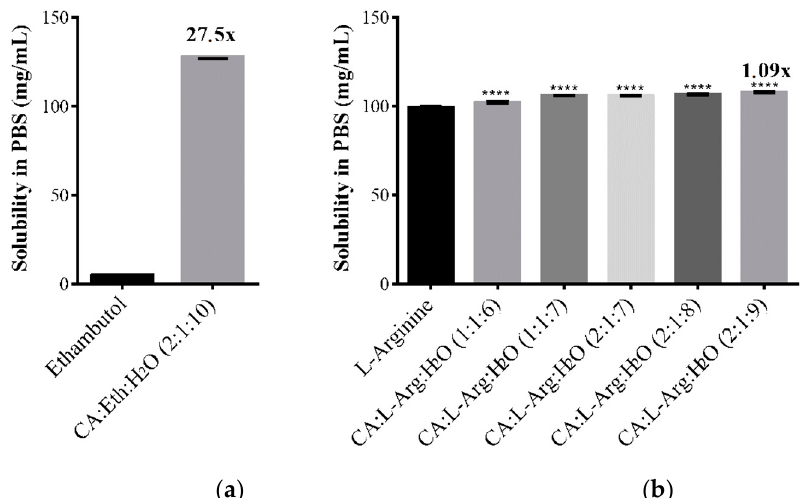
Figure 4. Solubility of THEDES and raw materials with ethambutol ( a ) and L -arginine ( b ), in PBS at 37 °C. Results are presented as mean ± standard deviation and statistically significant differences (****) are shown as p < 0.05 in comparison with raw material.